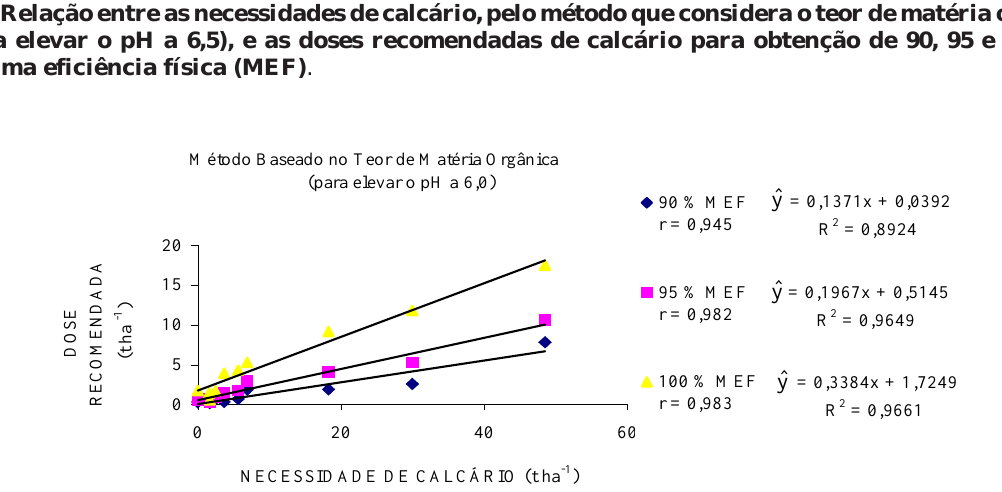
Figura 2. Relação entre as necessidades de calcário, pelo método que considera o teor de matéria orgânica (para elevar o pH a 6,0), e as doses recomendadas de calcário para obtenção de 90, 95 e 100% da máxima eficiência física